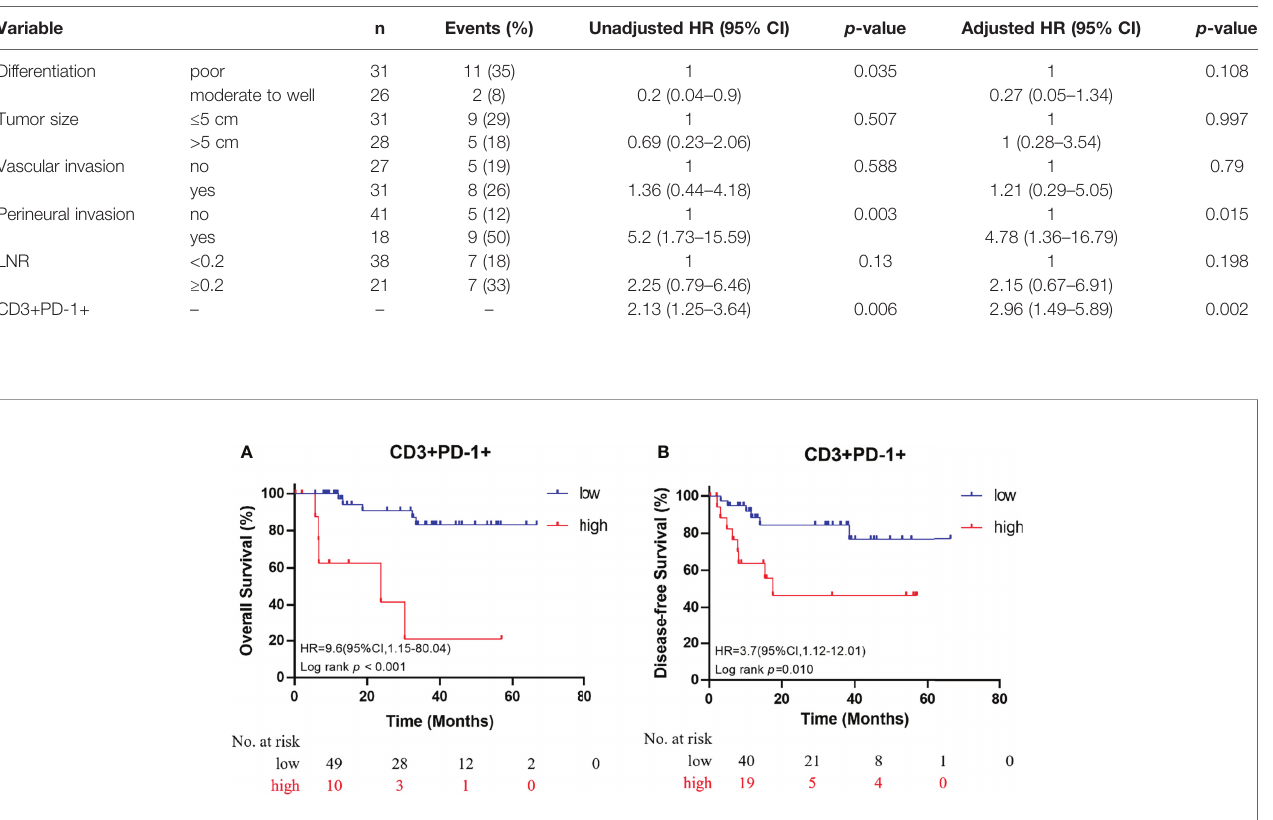
FIGURE 4 | Kaplan – Meier curves for overall survival (A) and disease-free survival (B) in patients with advanced-stage dMMR CRC, according to the proportion of dual-positive CD3+PD-1+